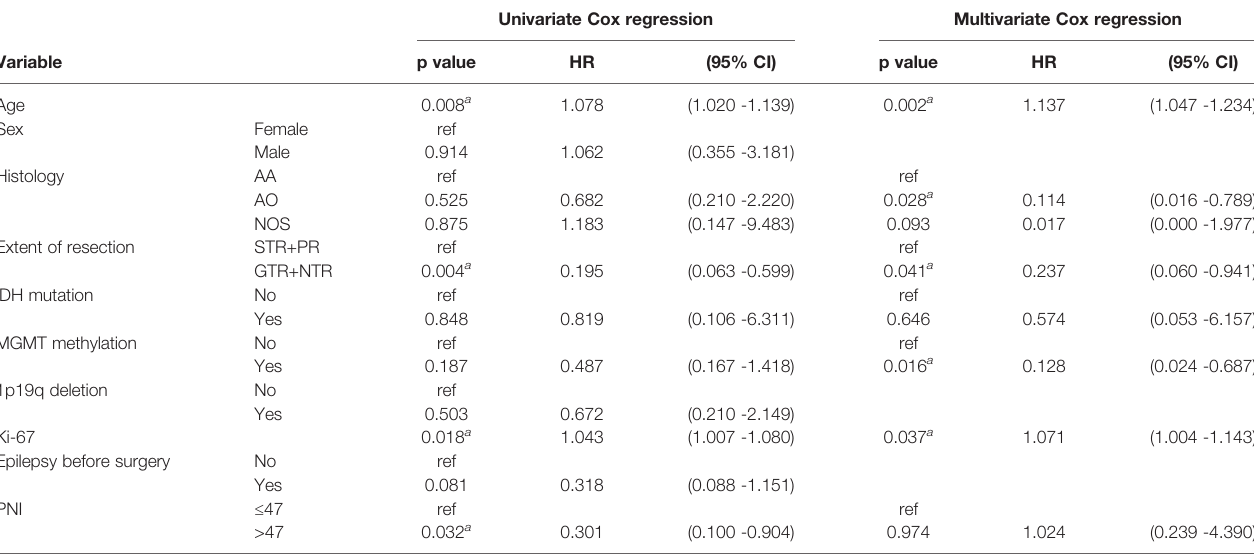
TABLE 4 | Univariate and multivariate Cox regression analyses for overall survival in grade III glioma patients. Univariate Cox regression Multivariate Cox regression